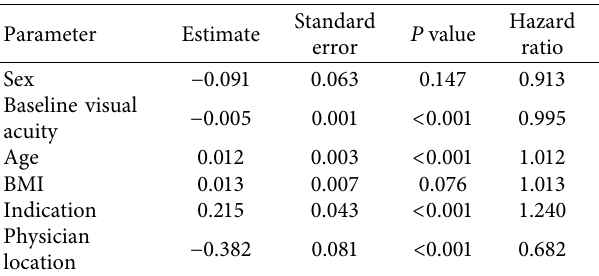
Table 4: Cox proportional hazard regression for occurrence of any